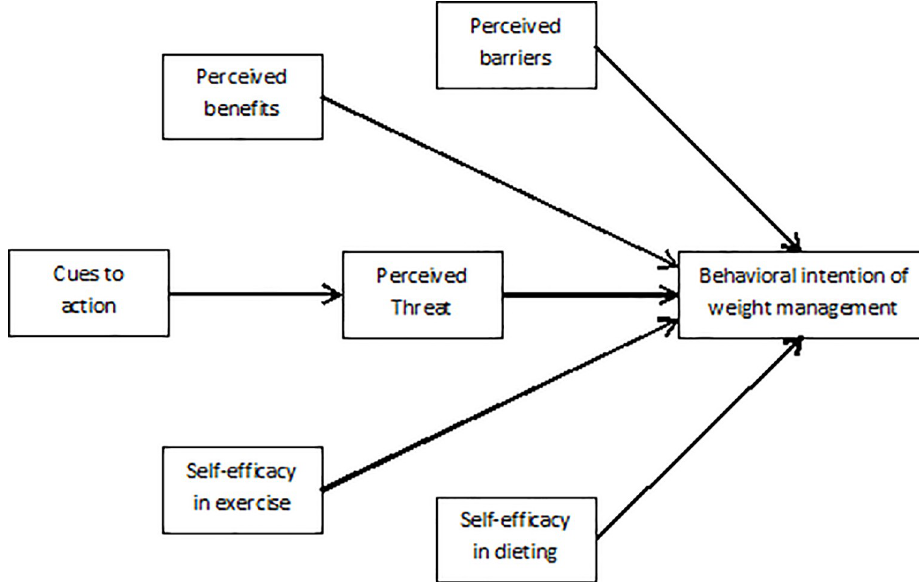
Fig 1. Theoretical framework of Health Belief Model applied to behavioral intention of weight